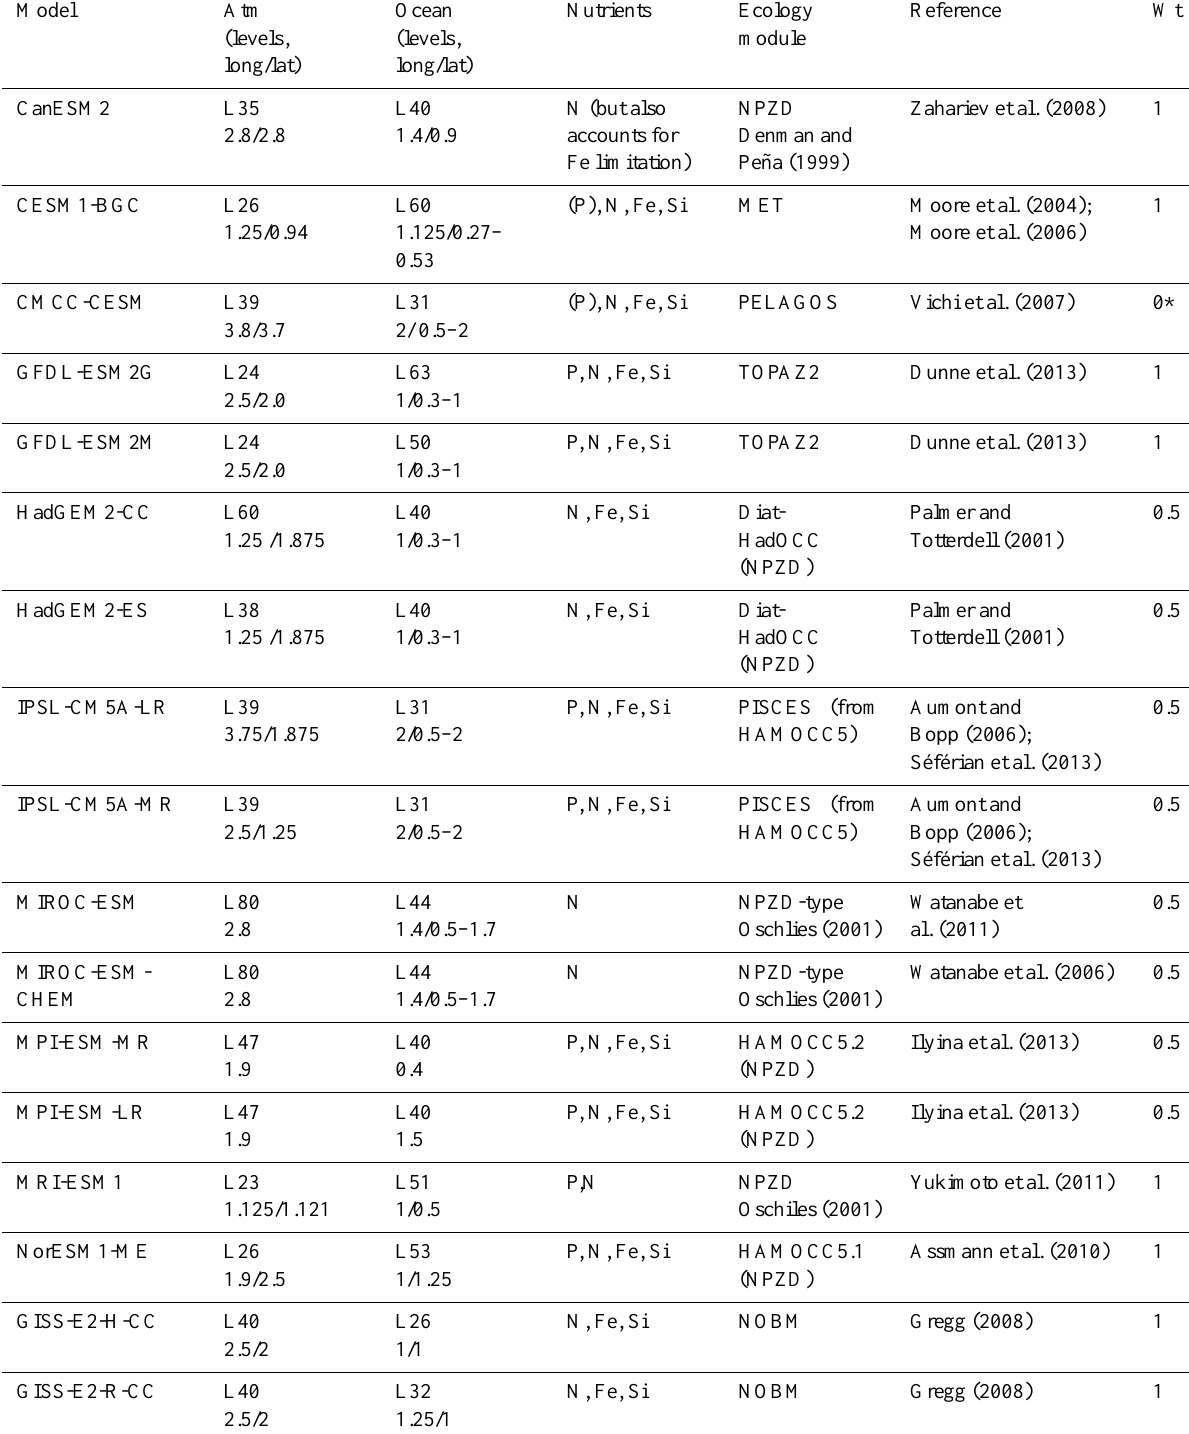
Table 1. CMIP5 model details. Summary of all the CMIP5 models that keep track of phytoplankton biomass and/or primary production with information on the following for each model: spatial resolution in the atmosphere and ocean, explicitly modelled nutrients, ecology subroutine, references and weight (wt) applied in the all-model averages. ( ∗ Note: CMCC-CESM runs did not appear to reach equilibrium, which was a necessary condition we imposed in order to work with a model; thus, we only show data from CMCC-CESM in the Supplement figures, but do not take this model into account in the all-model